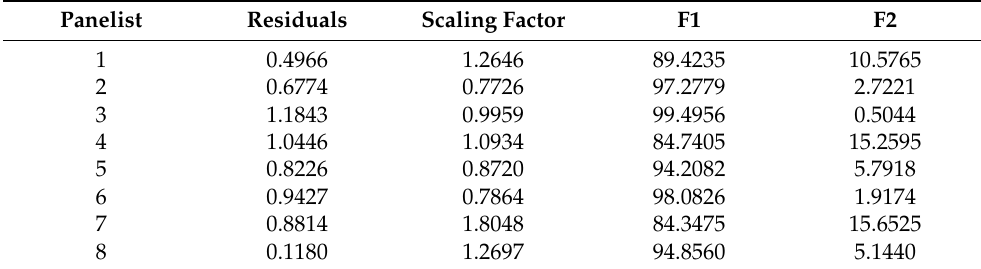
Table 5. Residual variance, scaling factors, and percentage variation explained by the first two principal components for each assessor for burger sensory